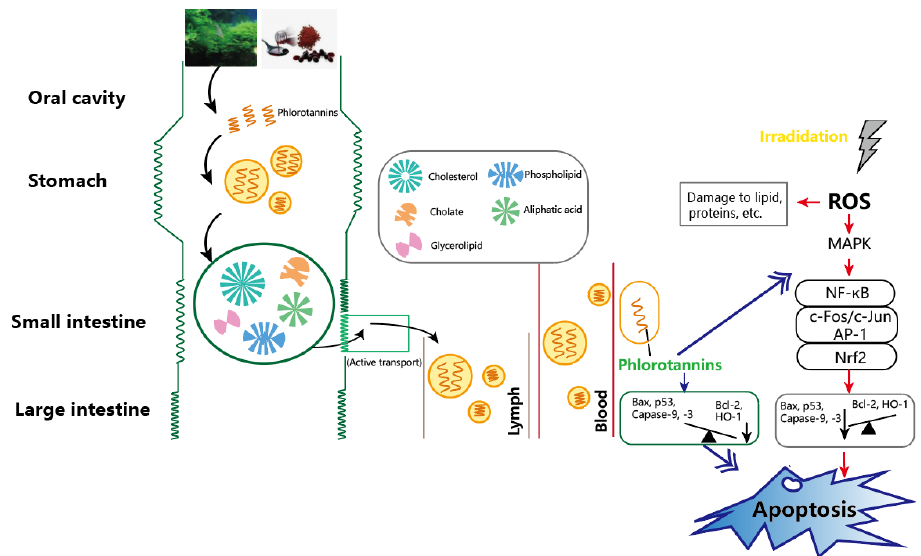
Figure 3. The mechanism of anti-radiation and antioxidant effects in humans from the active sub- stances of macroalgae.